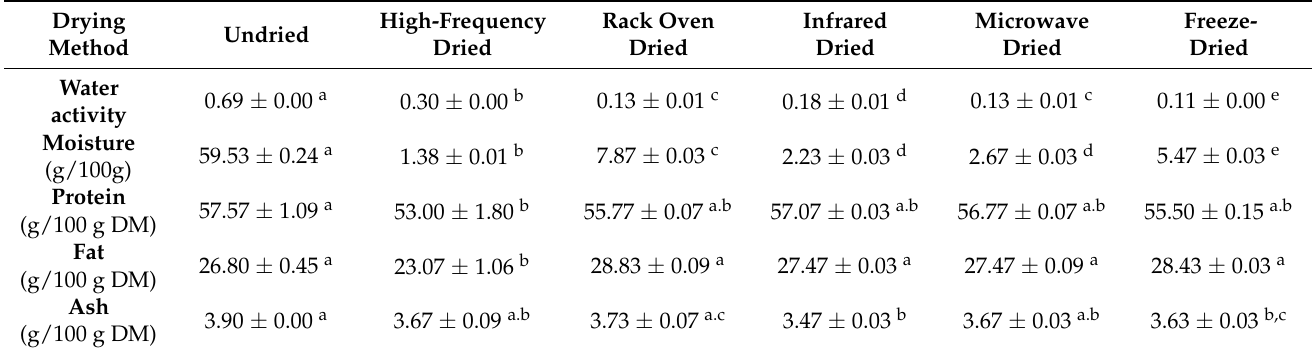
Table 2. Nutritional values of fresh and dried mealworm